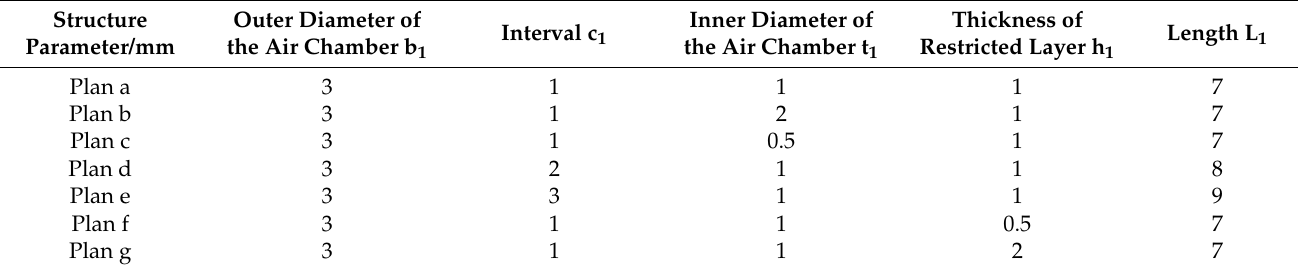
Table 1. Four-finger bending actuator structure scheme.